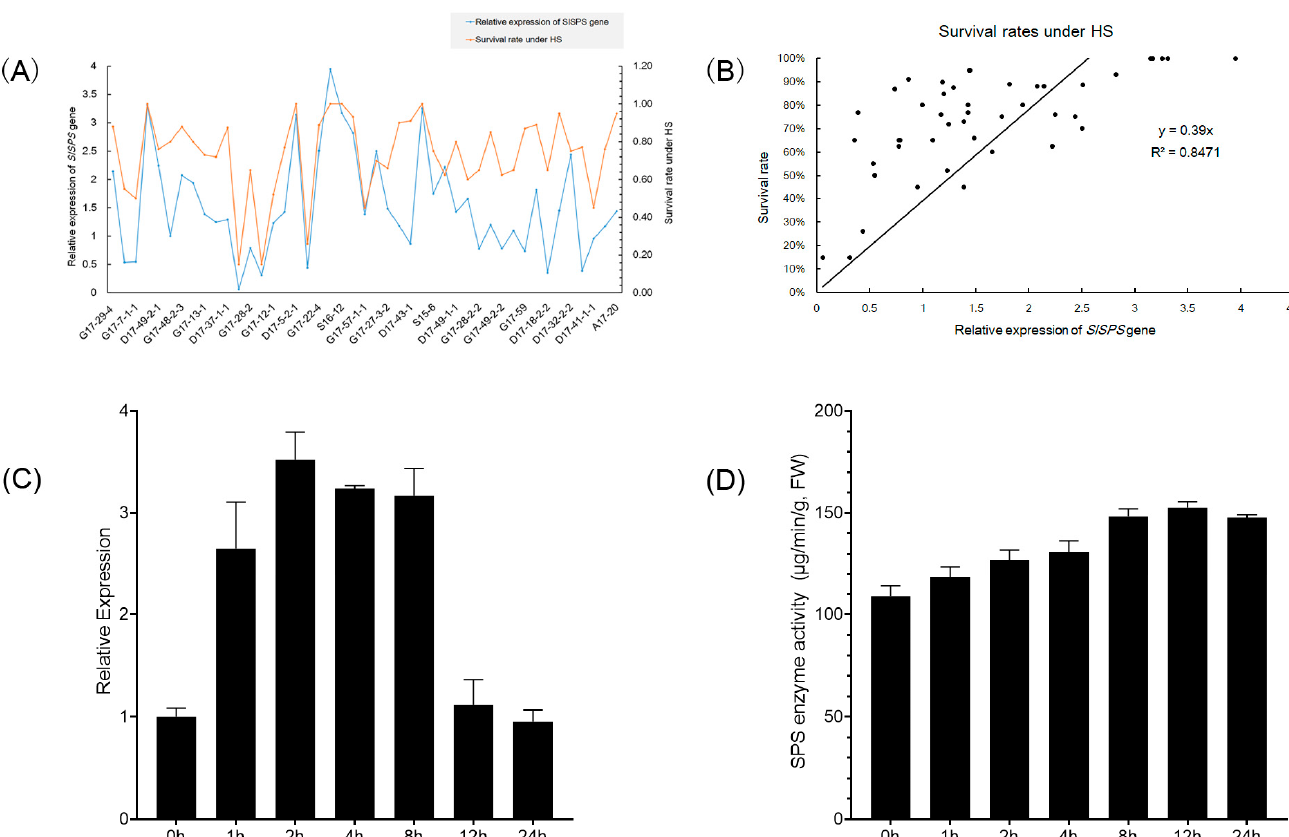
Figure 4. Relationship between survival rates and expression level of SlSPS gene under 2-week heat stress ( A , B ). (n = 20 for each varieties). The horizontal axis denotes tomato varieties used in this experiment ( A ). The scatters and regression curve represent the survival rates and expression level and their correlation ( B ). Expression level ( C ) and SPS enzyme activity ( D ) of Micro-Tom were analyzed at 0 h, 1 h, 2 h, 4 h, 8 h, 12 h and 24 h after high temperature treatment. Values in ( C , D ) are means ± SD. (n = 3 for each time point).